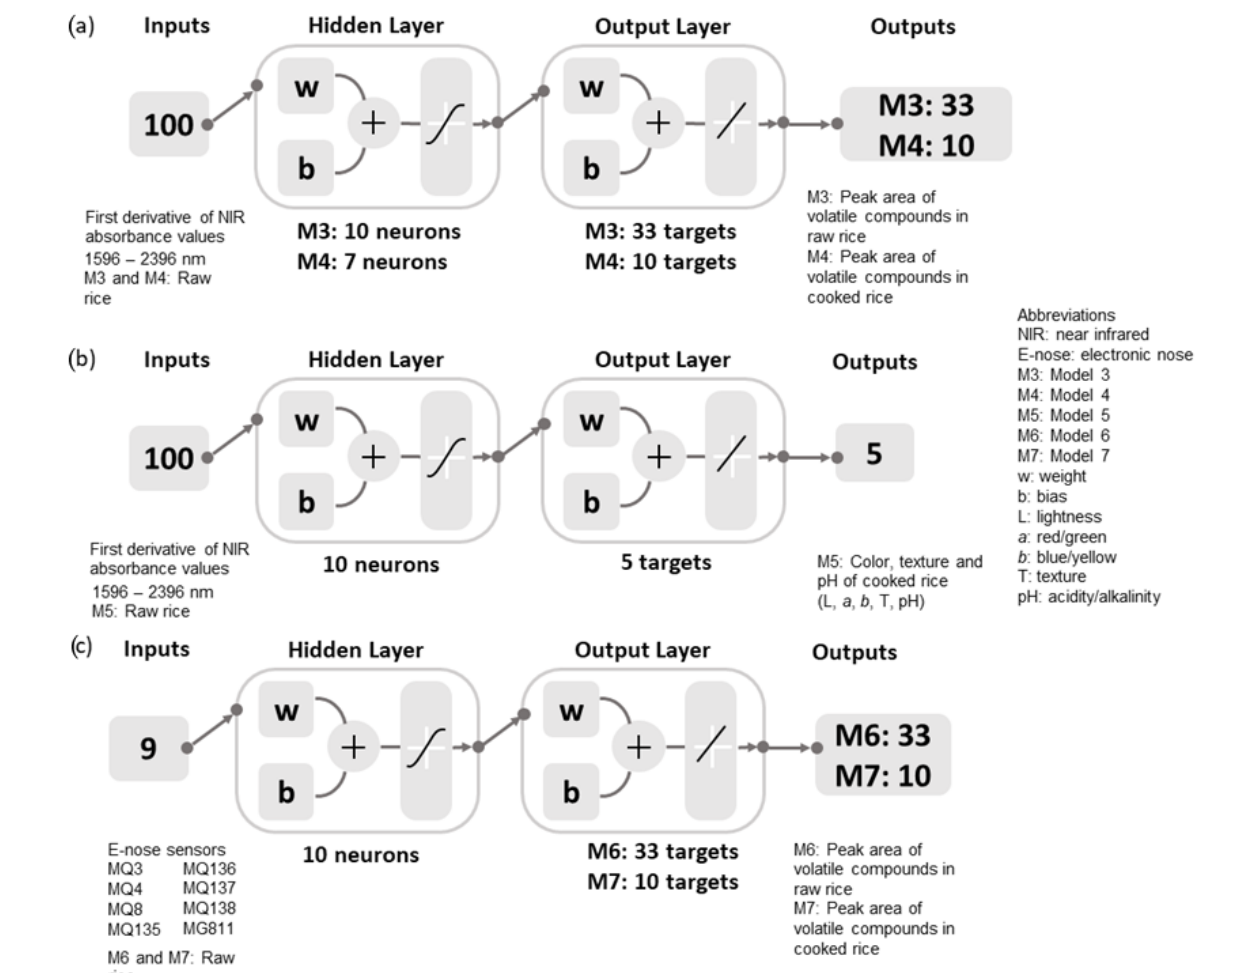
Figure 2. Regression models developed using the ( a ) first derivative of NIR absorbance values to estimate the aromas (Models 3 and 4) and ( b ) physicochemical quality (Model 5) of rice, and ( c ) electronic nose sensors ’ data as inputs to estimate rice aromas (Models 6 and 7). A description of the electronic nose sensors can be found in Table 2.